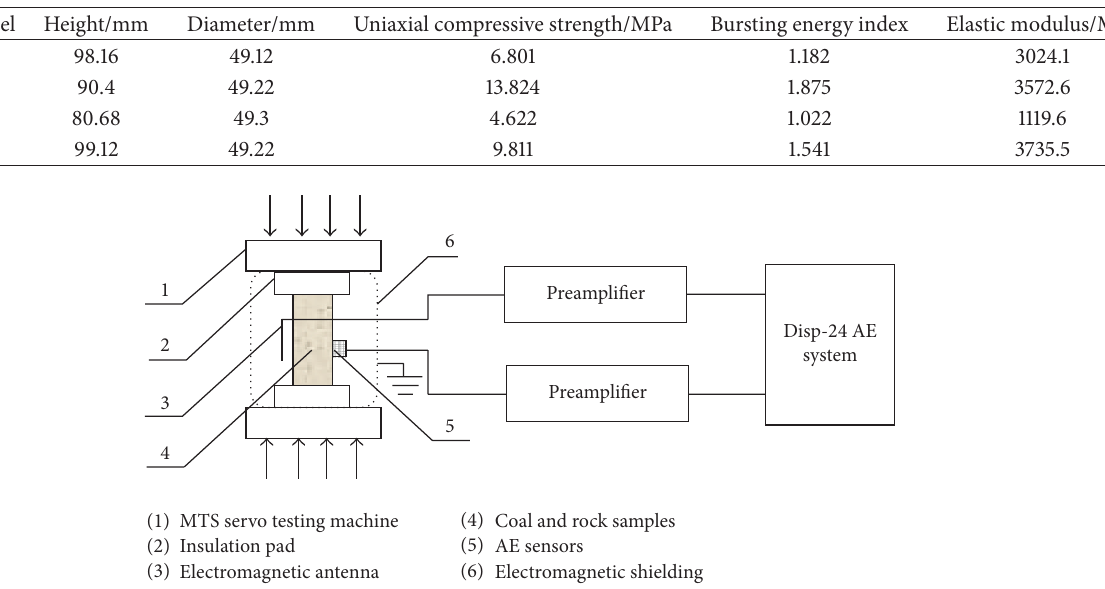
Figure 1: Schematic diagram of the experimental system.